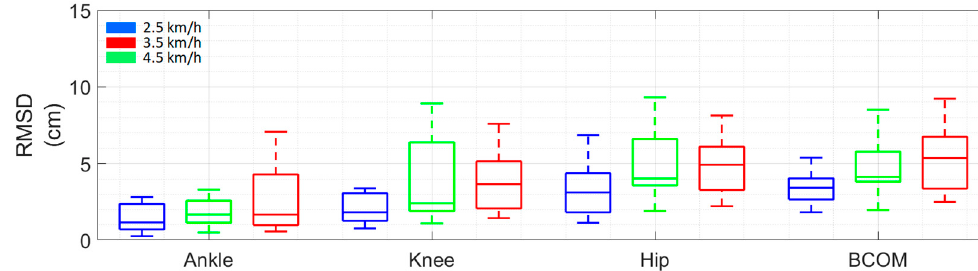
Figure 5. Root mean square deviation (RMSD) between trajectories computed using MIMU- and camera-based data for each walking velocity.